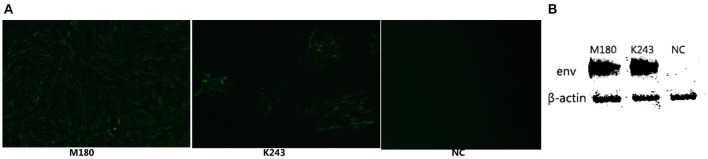
ALV-J strain identification by IFA and western blot analysis. The two ALV-J strains isolated from late and fast feathering chicken groups were detected by IFA and Western blot. (A) DF-1 cells infected with M180 strain isolated from late-feathering chicken and K243 strain isolated from fast-feathering chicken showing ALV-J specific green fluorescence, 150x magnification. (B) DF-1 cells infected with M180 and K243 produced specific ALV-J envelope protein blots. Uninfected DF-1 cells were used as a negative control (NC).